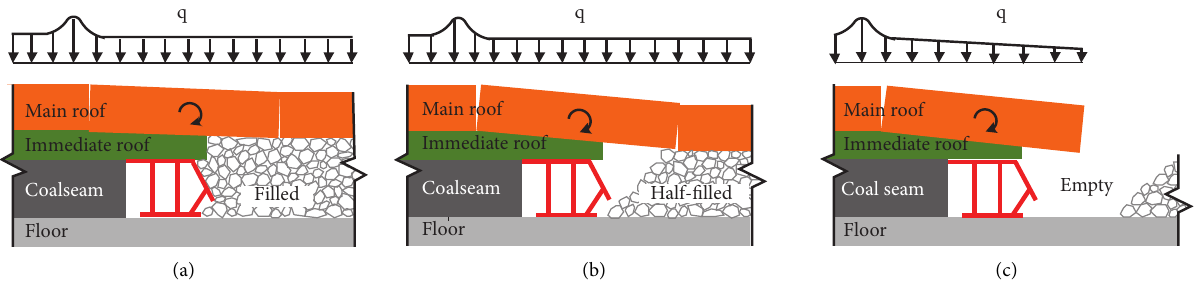
Figure 7: Interaction relationship of “support-surrounding rock” system along the strike. (a) Lower area of inclined direction; (b) middle area of inclined direction; (c) upper area of inclined direction.